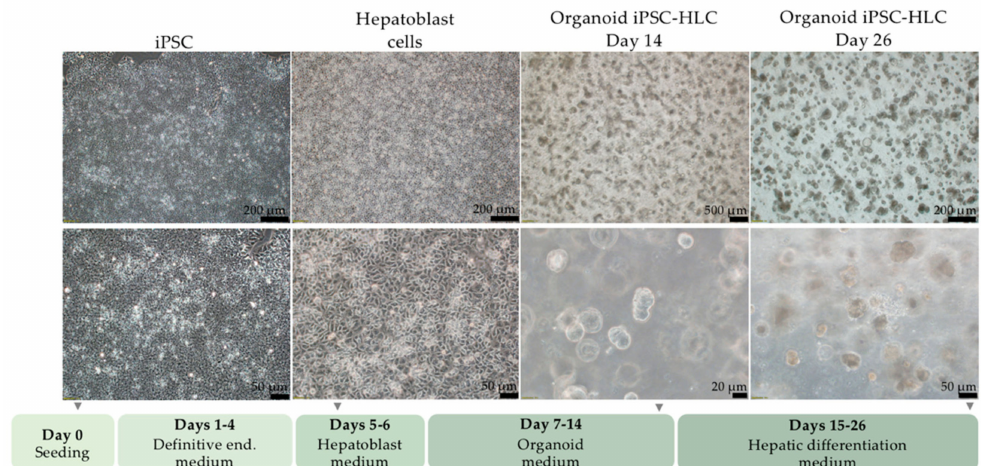
Figure 4. Stages of hepatic differentiation. Representative pictures of iPSC differentiation towards hepatoblast, and eventually organoid iPSC hepatocyte-like cells (iPSC-HLC) are shown at different magnifications. Synopsis of differentiation protocol is shown at the bottom of the figure. Scale bar indicated in each